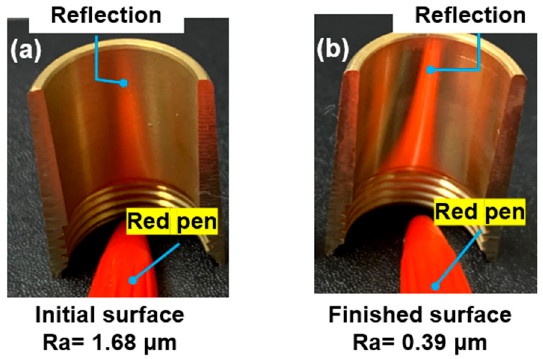
Figure 9. ( a ) Mirror image before finishing, ( b ) Mirror image after finishing.